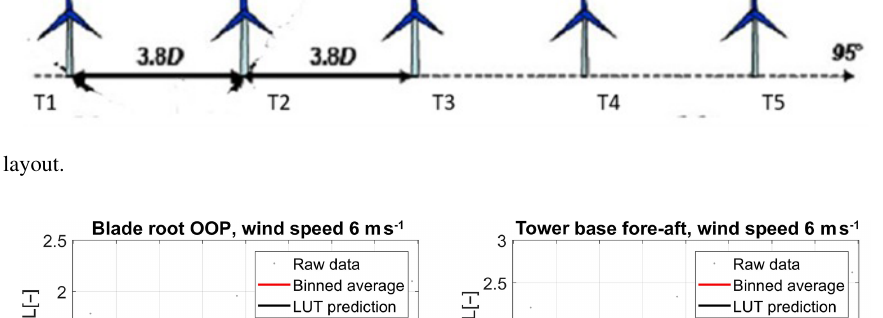
compared to the LUT predictions for different wind speeds. The blade root out-of-plane loads (left plots in the figures) and tower bottom fore–aft loads (right plots) are given. The grey dots in the plots represent the raw (filtered and normal- ized) measurements, while the red solid lines give the binned averages of these data points. The solid black lines depict the normalized LUT load